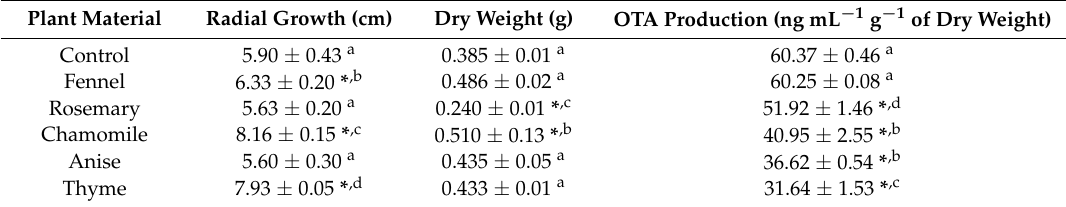
Table 2. Radial growth (cm), dry weight of Aspergillus carbonarius S402, and OTA production (ng mL − 1 g − 1 of dry weight) after four days of culture at 28 ◦ C on Synthetic Grape Medium (SGM) supplemented with the five phenolic extracts at 250 µ g GAE mL − 1